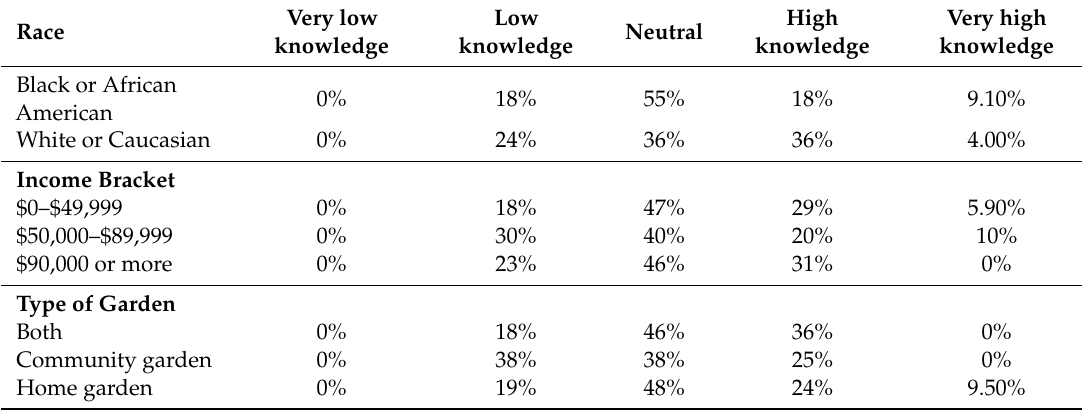
Table A12. Knowledge of participants regarding resources to learn about soil remediation.